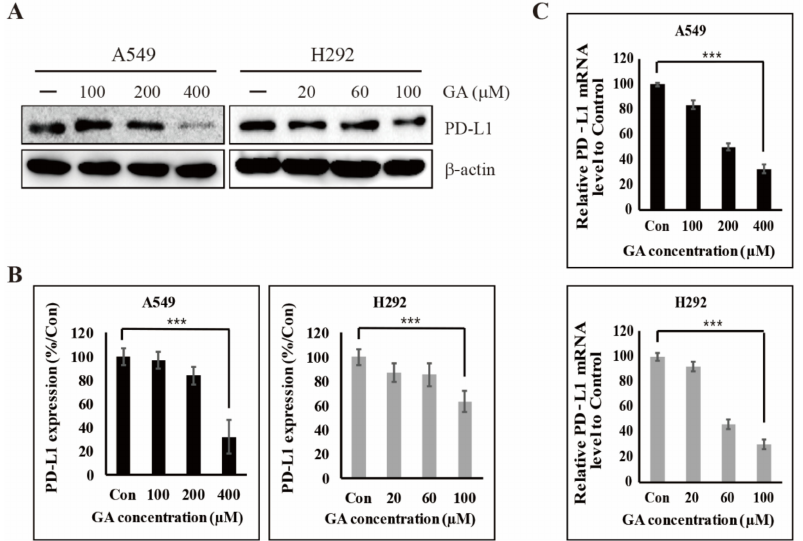
Figure 1. Gallic acid (GA) reduces the programmed death-ligand 1 (PD-L1) expression in non-small-cell lung cancer (NSCLC) cells. ( A ) The expression levels of PD-L1 protein in A549 and H292 cells were detected after GA treatment in concentrations indicated for 48 hours. ( B ) The relative expression levels of PD-L1 protein were determined by densitometry and normalized to β -actin. Data are representative of three independent experiments. *** p < 0.001 ( t- test). ( C ) The expression levels of PD-L1 mRNA in A549 and H292 cells were detected after GA treatment in concentrations indicated for 48 hours. The relative expression levels of PD-L1 mRNA were determined by real time qPCR and normalized to GAPDH mRNA. Data are representative of three independent experiments. *** p < 0.001 ( t-